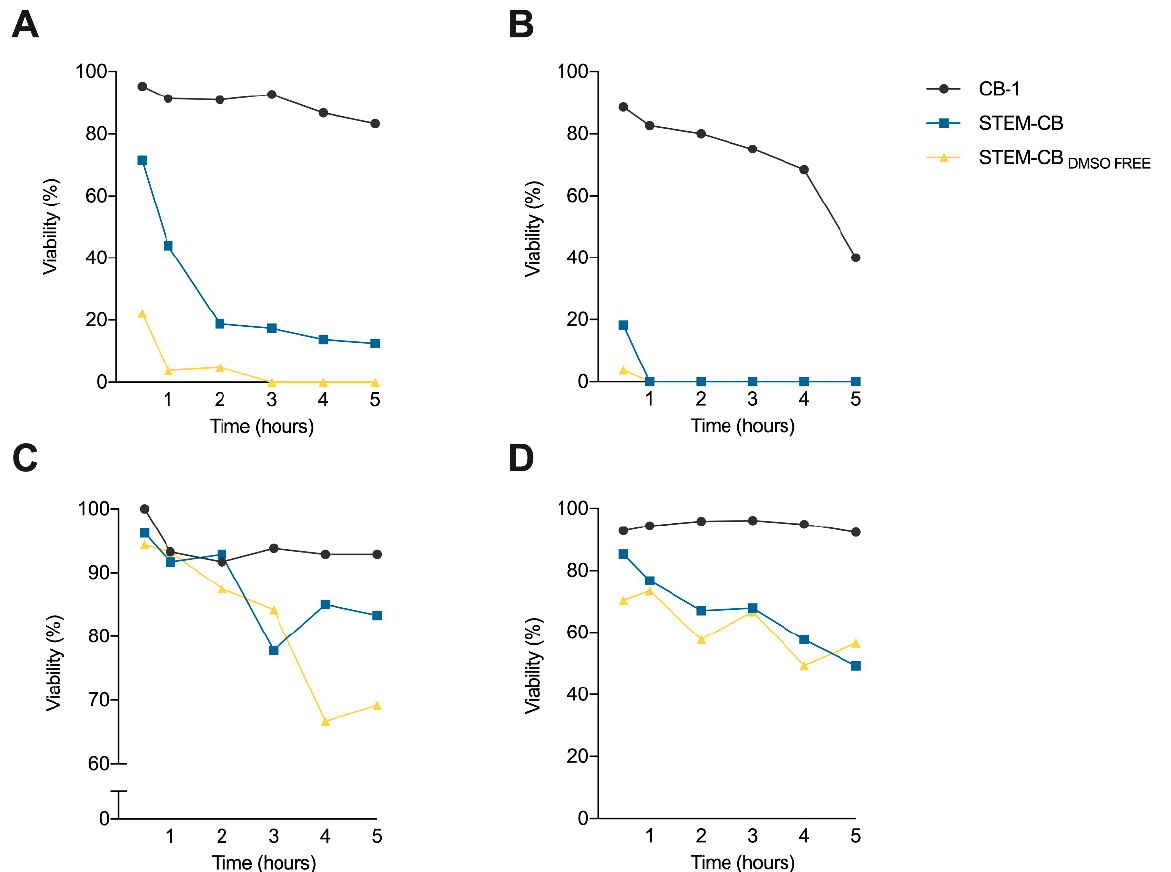
Figure 4. Cells ( n = 1) were suspended in CellBanker-1 (CB-1), STEM-CELLBANKER (STEM-CB), or STEM-CELLBANKER without DMSO (STEM-CB DMSO FREE ) and kept for up to 5 h on ( A , B ) room temperature or kept ( C , D ) on ice. Cell viability tested at multiple time points either before or after 1 day of cryopreservation.